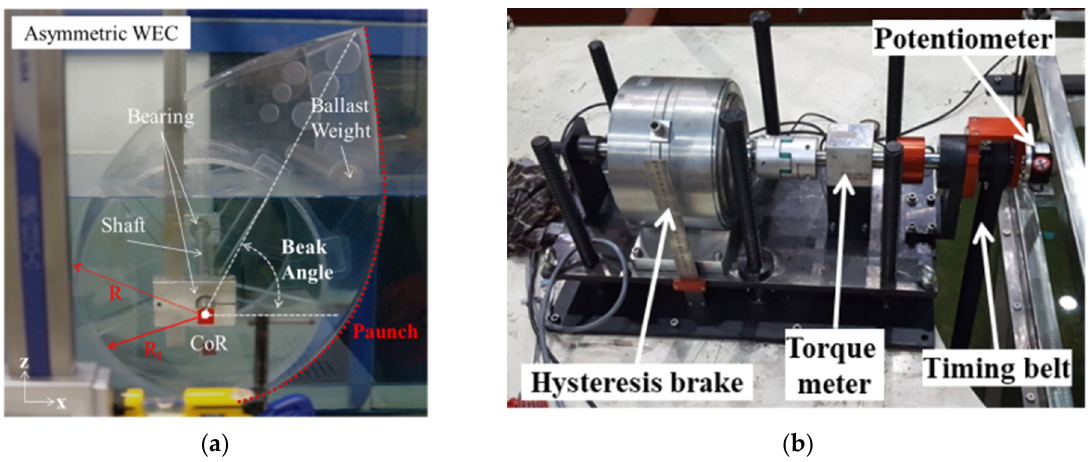
Figure 2. Definition and snapshot of the experimental set-up. (a) Asymmetric WEC and (b) PTO load torque system.